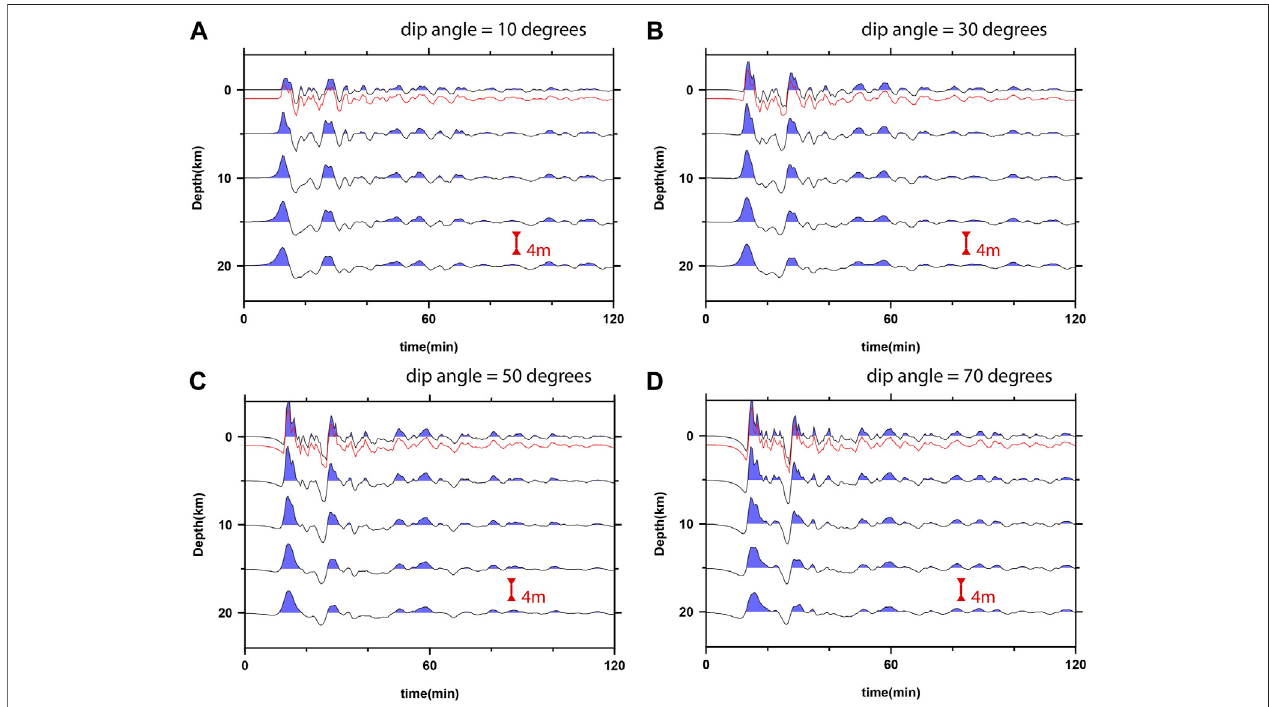
FIGURE14| Offshoretime-seriesoftsunamisurfaceelevationasafunctionofdipangleanddepthfortsunamisfromearthquakesourceswithrake (cid:1) 90 o andstrike (cid:1) 0 o . The scenario with the top of the fault at 1 km depth is displayed in red and was included fi rst and foremost as a check that there was no fundamental or qualitative difference between having the top of the fault plane at zero or close to zero. Panels (A – D) show the results using dip angles of 10 ° , 30 ° , 50 ° , and 70 ° respectively.